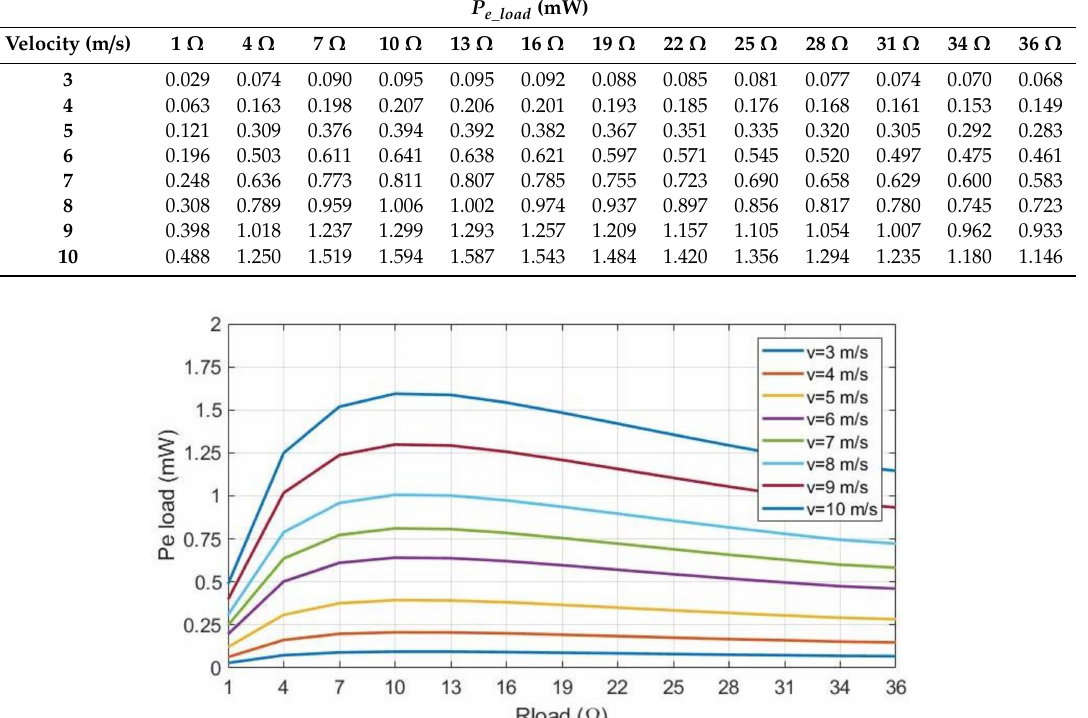
Figure 9. Calculated harvester power values for di ff erent loads and air